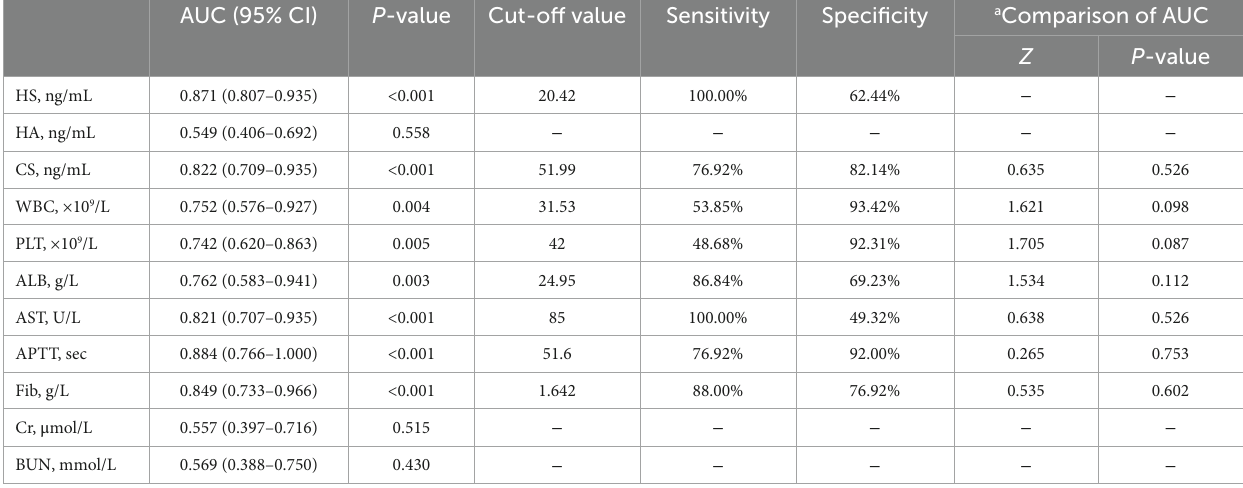
TABLE 3 Predictive efficacy of heparan sulfate (HS), hyaluronic acid (HA), and chondroitin sulfate (CS) and conventional laboratory parameters. AUC (95% CI) P -value Cut-off